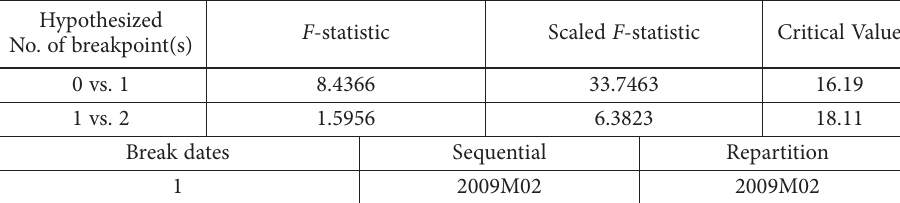
Hypothesized No. of breakpoint(s)